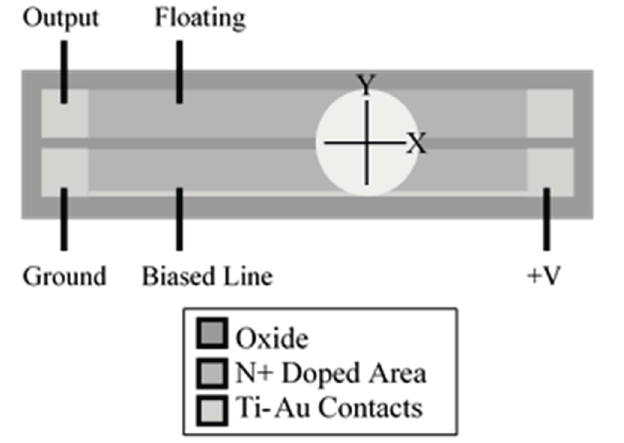
Figure 5. Schematic drawing of light spot